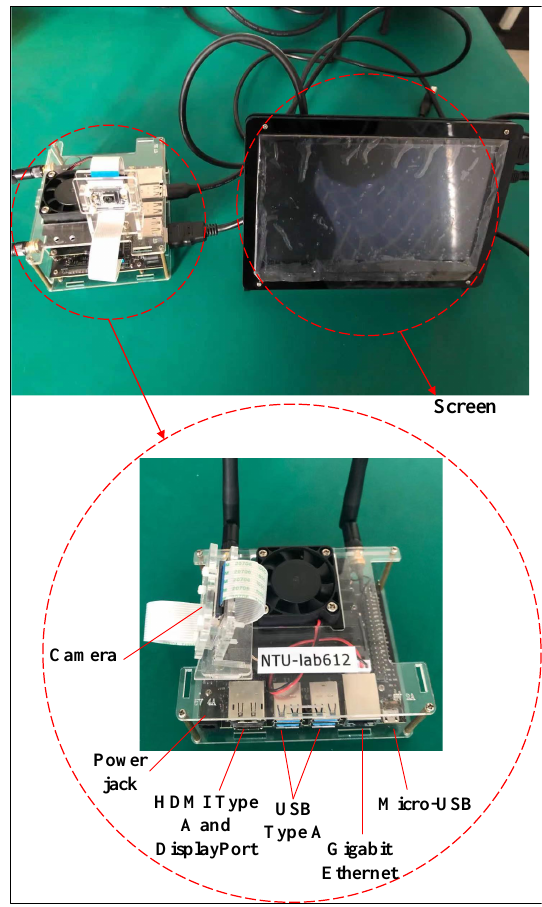
Figure 7. Jetson Nano B01 development